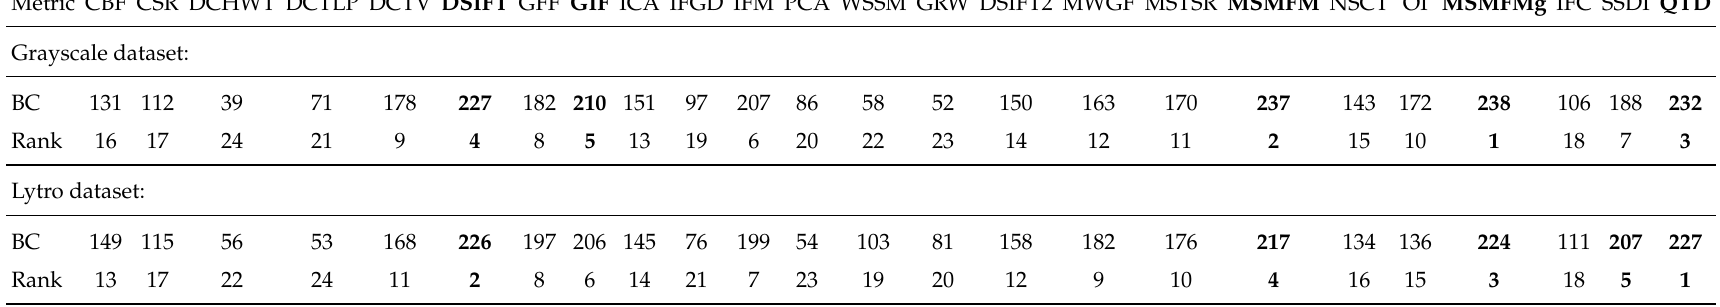
Table 7. Borda count results on test datasets. BC represents the cumulative Borda count score of each algorithm. The best five algorithms are marked in